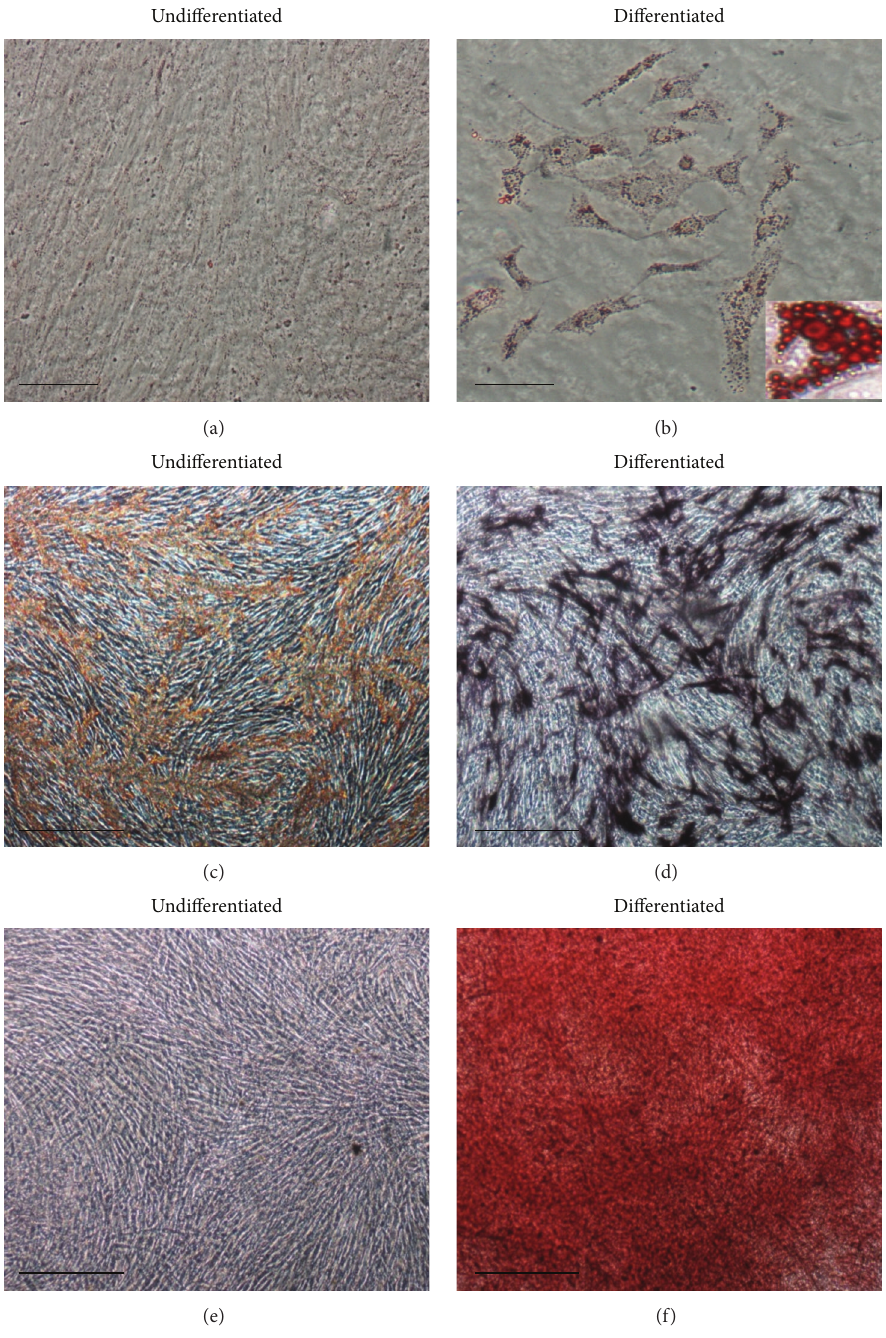
Figure 3: In vitro mesodermal differentiation of FL-MSCs. (a, b) Adipogenic differentiation, oil red O staining after 21 days of culture in adipogenic medium (b) or corresponding control cultures (a). Bar = 20 𝜇 m. (c, f) Osteogenic differentiation, alkaline phosphatase staining after 6 days of culture in osteogenic medium (d) or corresponding control cultures (c). Alizarin red staining after 21 days of culture in osteogenic medium (f) or corresponding control cultures (e). Bar = 50 𝜇